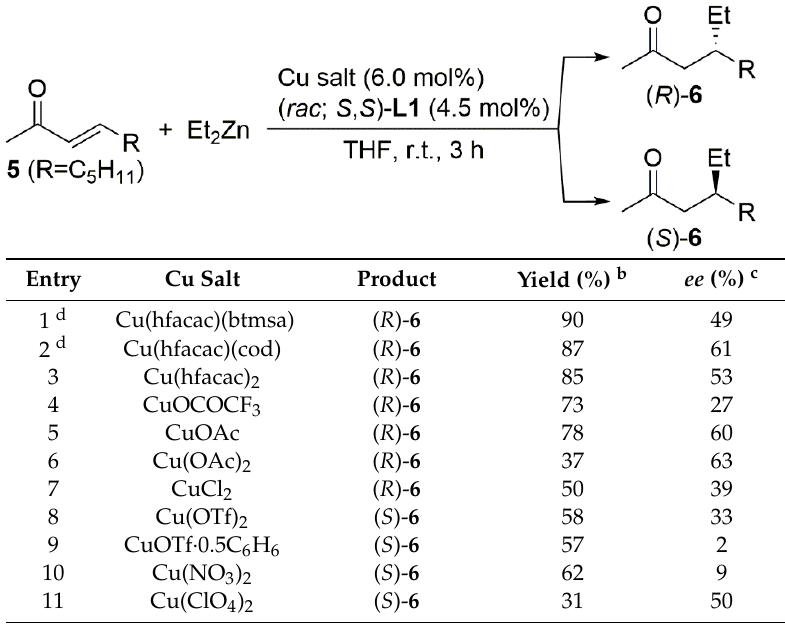
Table 4. Switching of stereoselectivity in the conjugate addition reaction of acyclic enone 5 a .